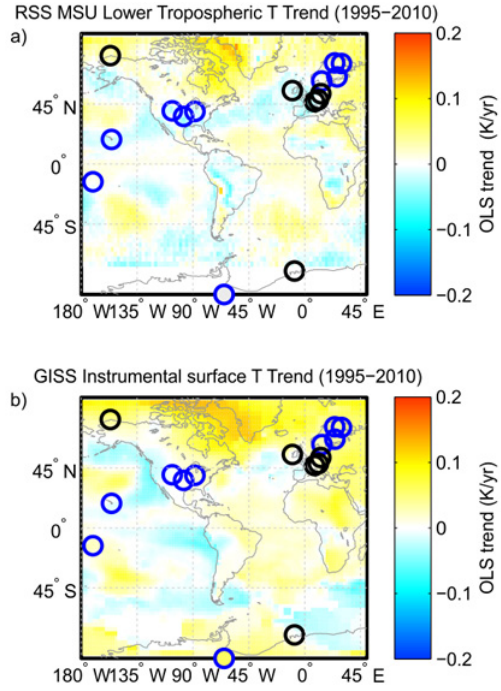
Fig. 6. Same as Fig. 5, but for period of 1995–2010. Note that some of the stations’ CN trends are not for the complete period of 1995– 2010, see Table 2 for the maximum